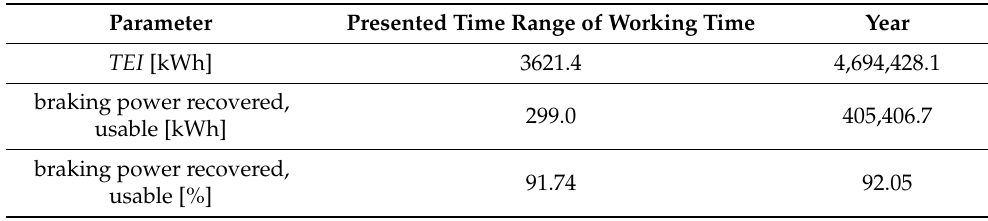
Table 6. Characteristics of variant after timetable reconfiguration.